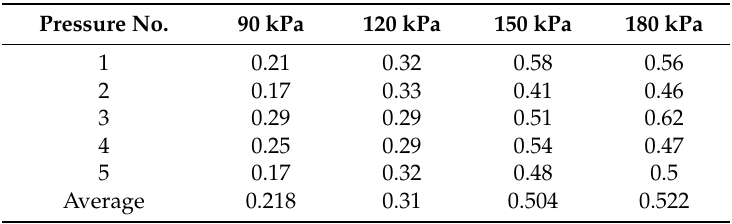
Table 1. Peak force (N) for the pulling